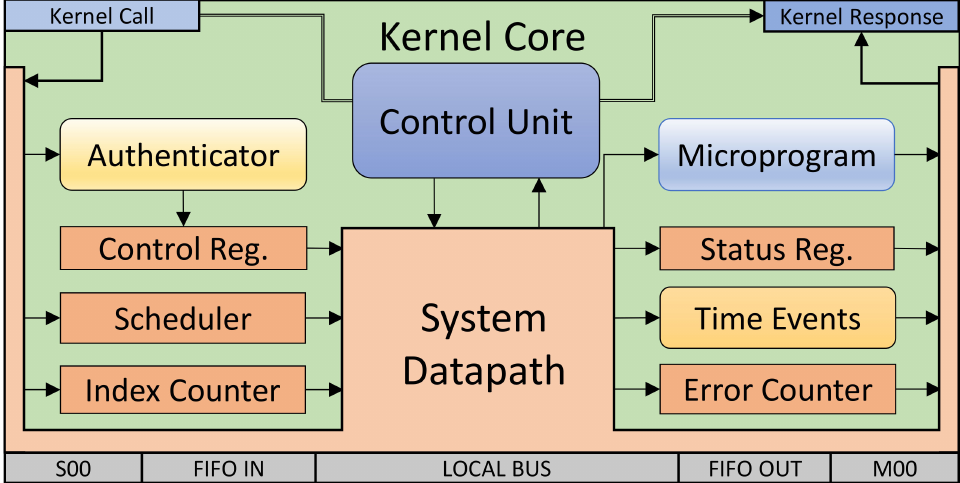
Figure 4. Kernel Core internal